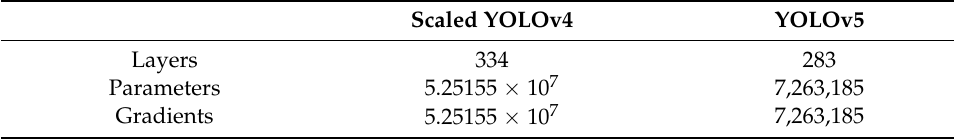
Table 3. Comparison between scaled YOLOv4 and YOLOv5.